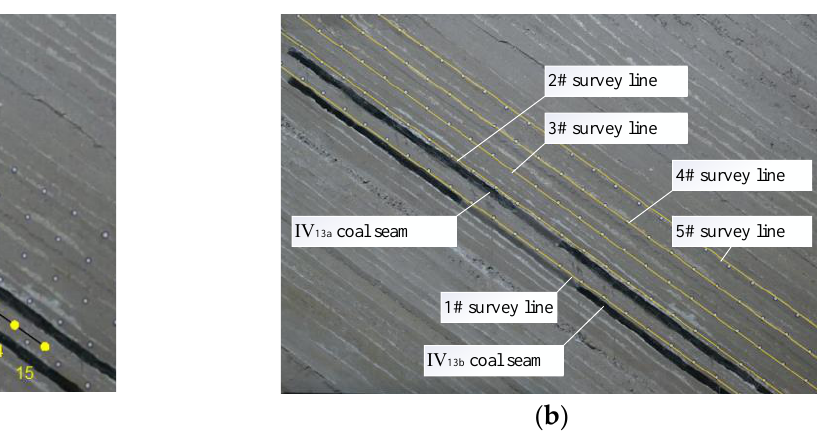
Figure 3. Construction of similar simulation experiment model. ( a ) Model design and size; ( b ) laying model.